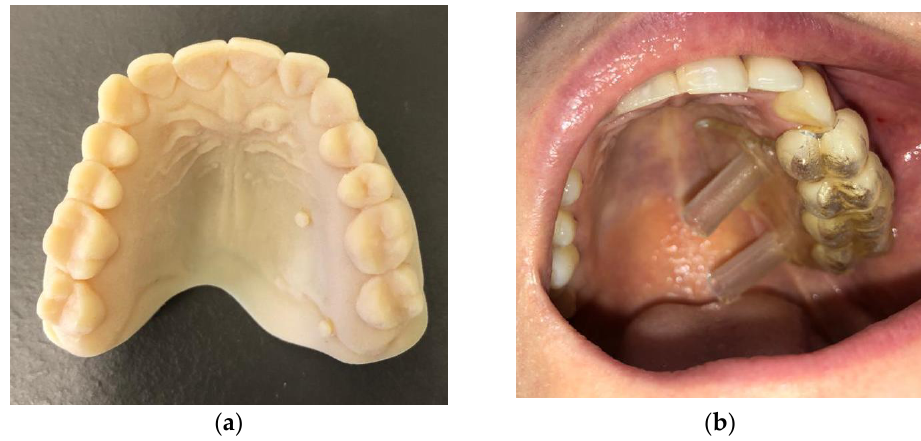
Figure 5. Surgical guide for the two screws in the second quadrant: ( a ) 3D printed cast; ( b ) Surgical guide applied in the oral cavity.